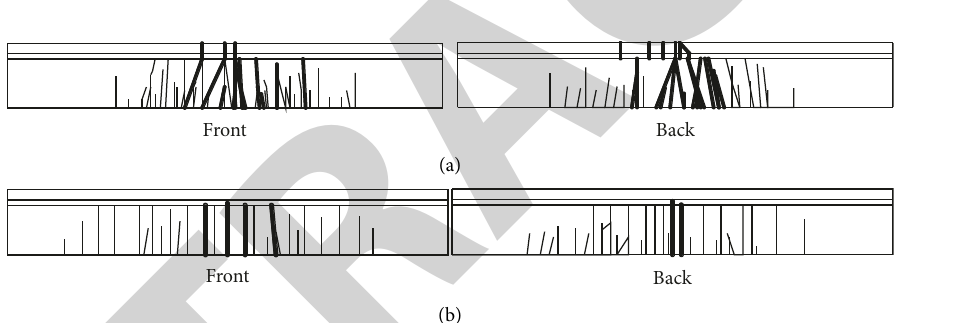
Figure 6: Overall development law of test girder major crack width.